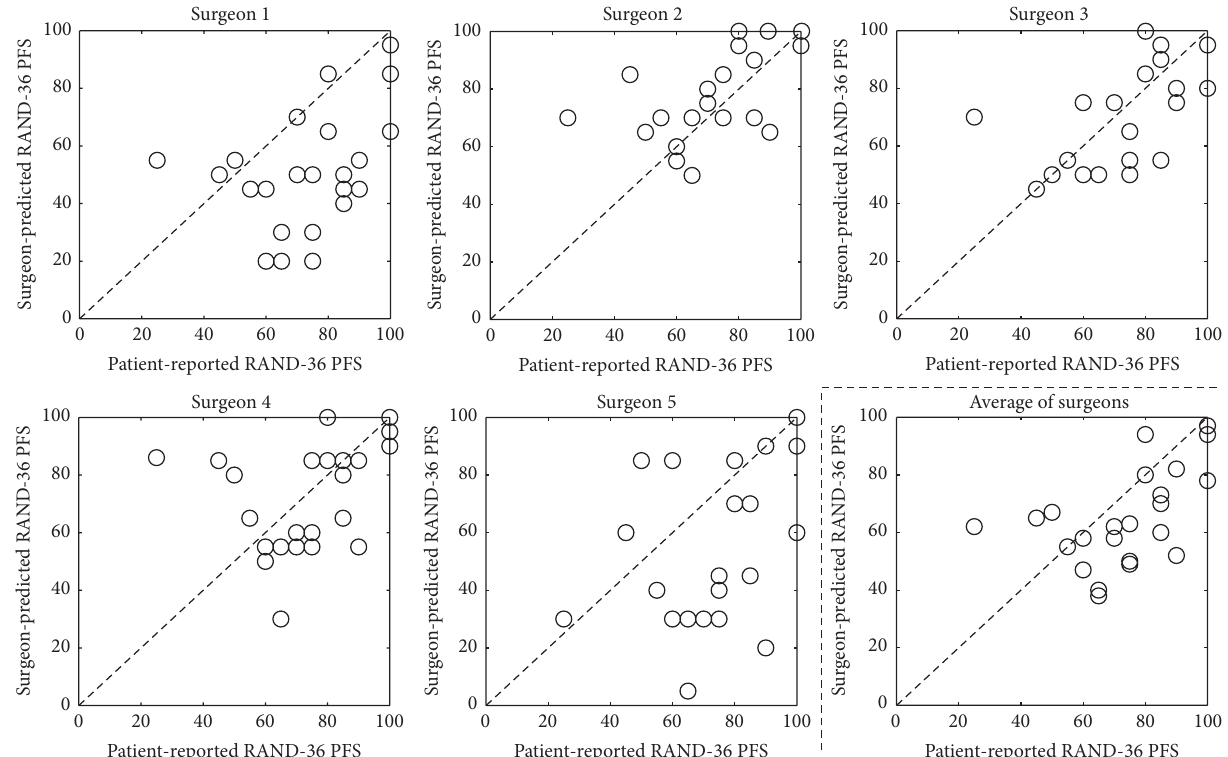
Figure 4: Scatter plots of patient-reported outcome and orthopedic tumor surgeon predictions on the RAND-36 physical functioning subscale (RAND-36 PFS). The dashed lines indicate a hypothetical perfect correlation; if a patient case lies above or below this line, the functional outcome was overestimated or underestimated,